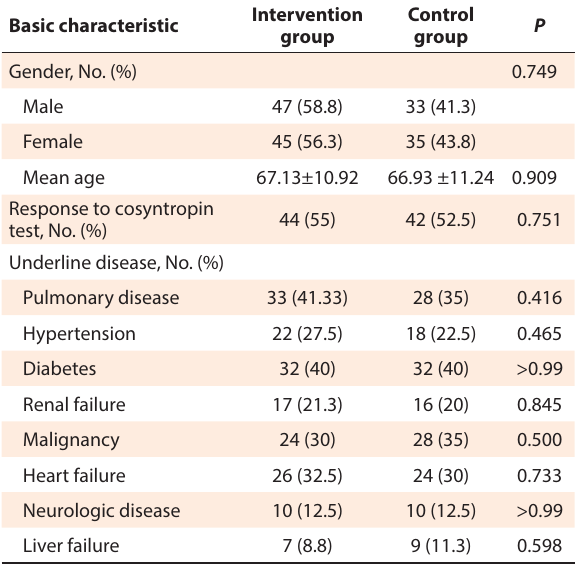
Table 1. Basic characteristic of intervention and control groups Basic characteristic